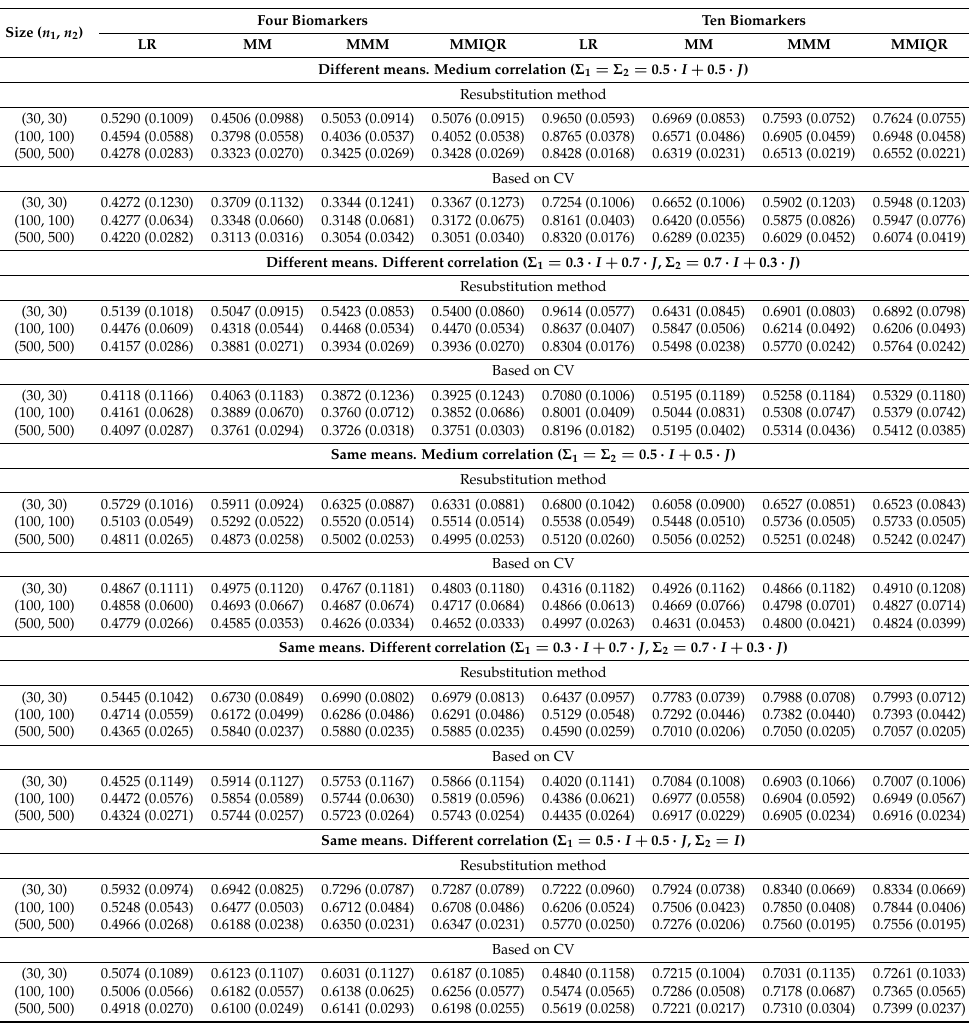
Table 3. Mean and standard deviation maximum Youden indices for 1000 random samples: Non- normal distributions.